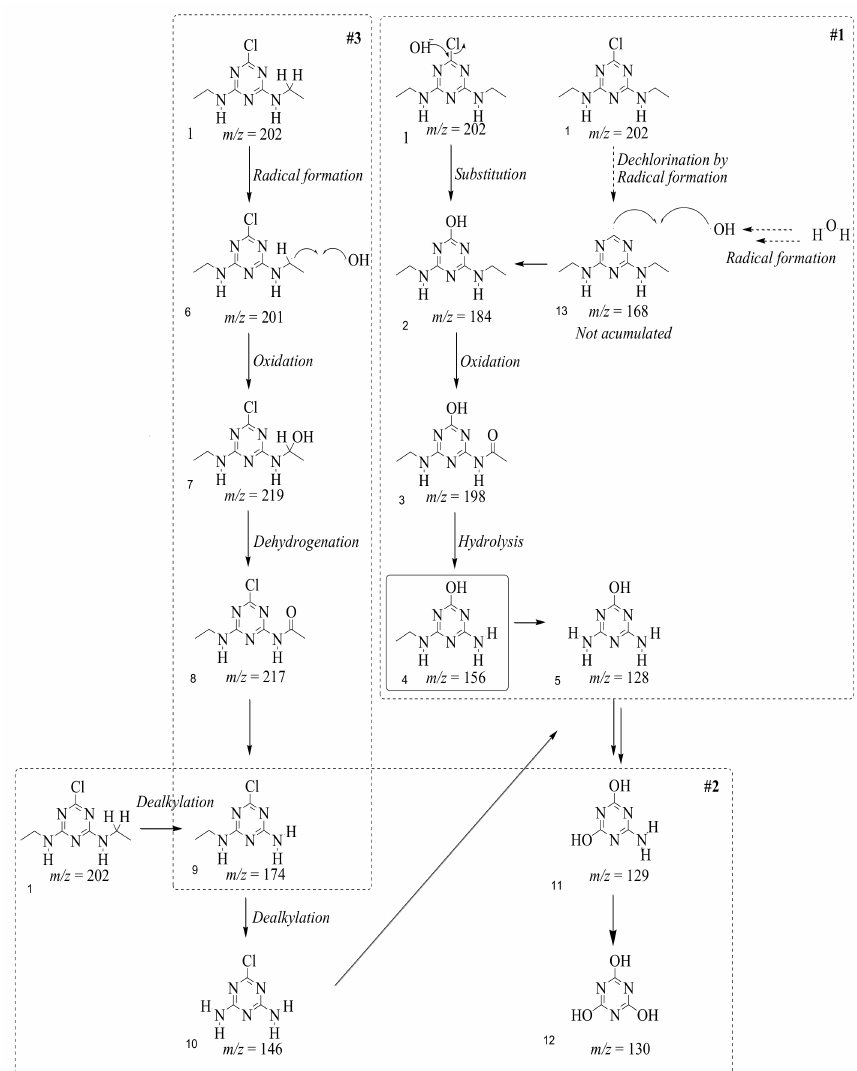
Figure 8. Proposed degradation pathways of